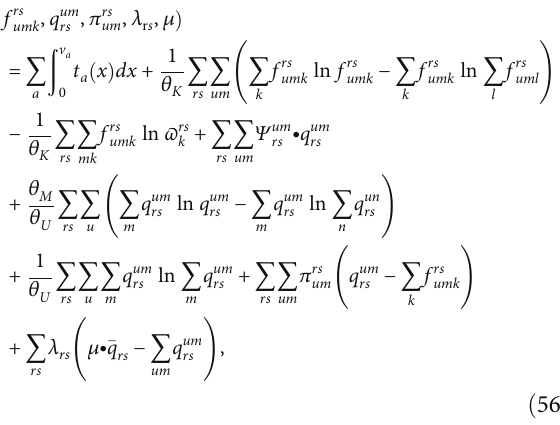
Figure 8: A bimodal network